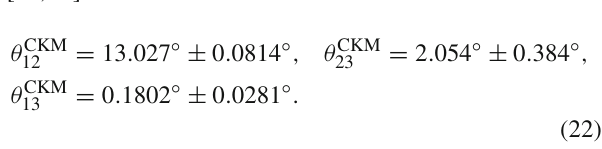
times 1 σ error interval in Eqs.(22) and (23).